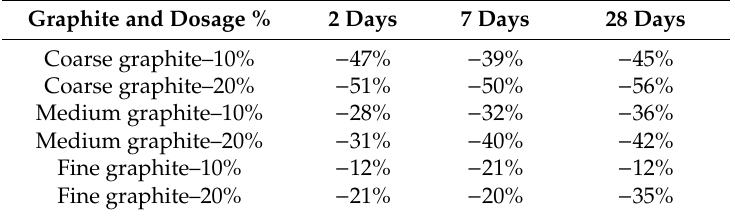
Figure 8. E ff ect of graphite fineness on the compressive strength of cement paste ( w / c = 0.45) at 2, 7, and 28 days. Table 2. Reduction in compressive strength (%) with the three di ff erent graphite